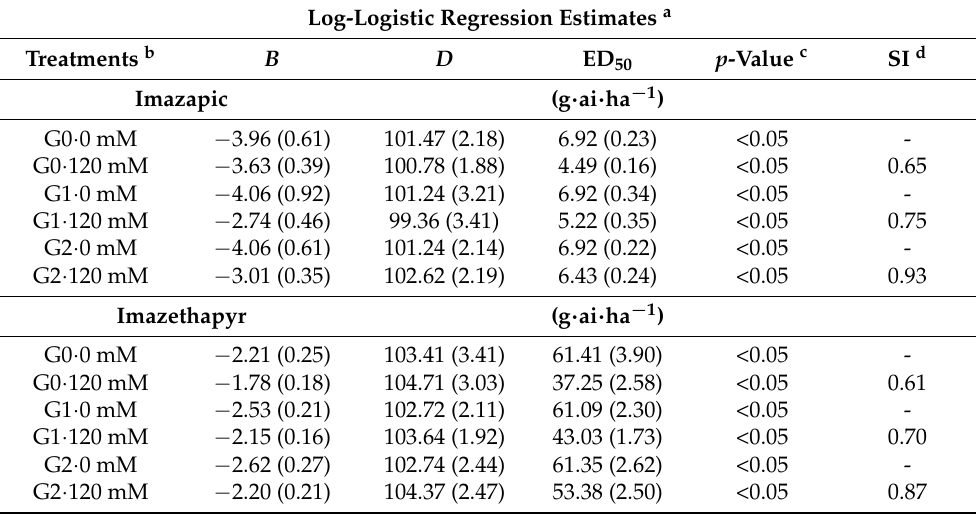
Table 2. Parameter estimates (b, d, ED 50 , and TI) for the three-parameter log-logistic regression model fitted to the dose-response of Echinochloa colona to imazapic. Log-Logistic Regression Estimates